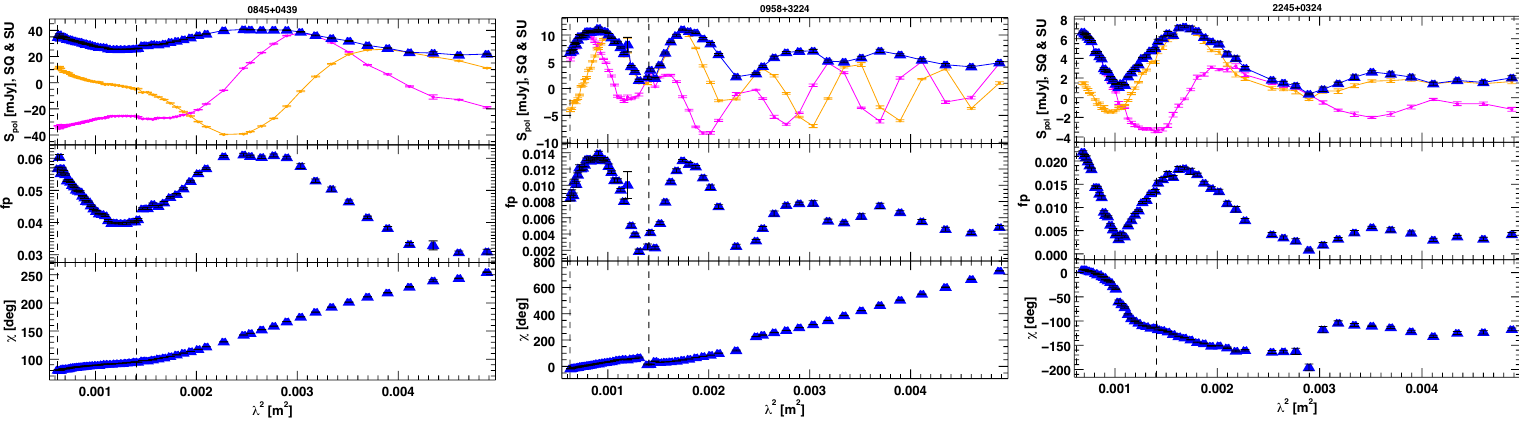
Figure 2. Polarization measurements of the sources at C and X bands. In the first panel: polarization flux density in blue, orange line is Stokes Q, and pink line is Stokes U; second panel: fractional polarization; third panel: polarization angle. Vertical dashed lines are the C/X band